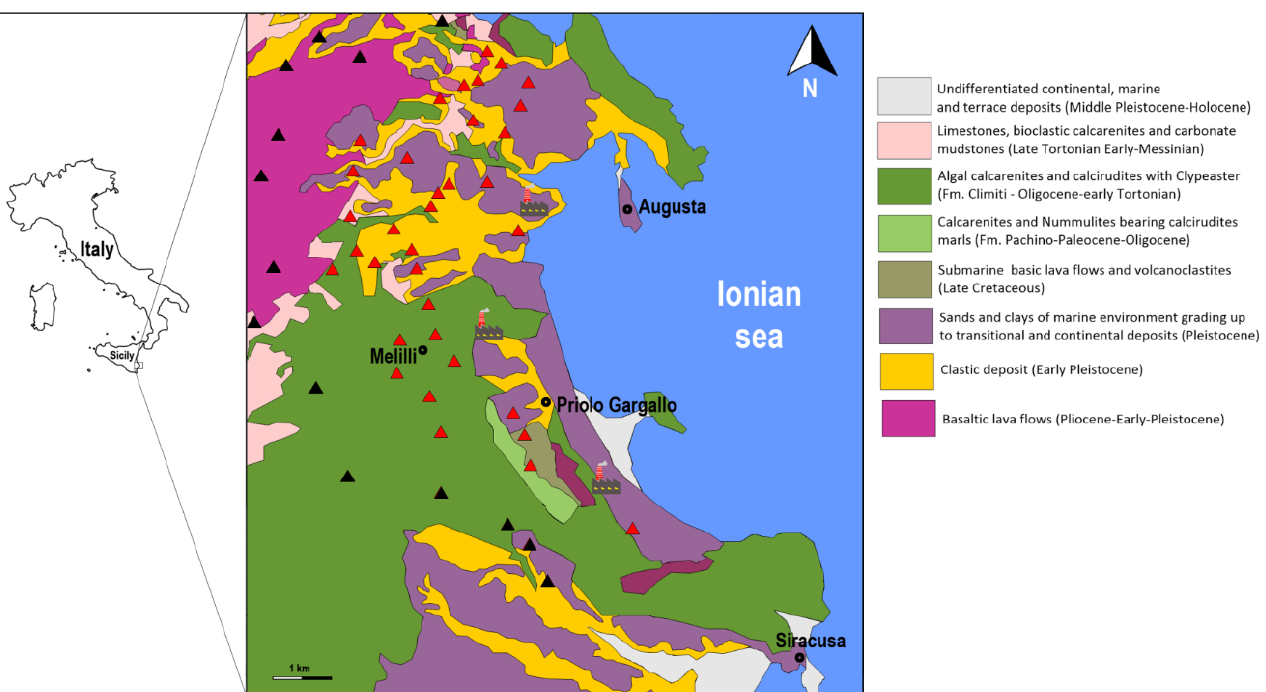
Figure 1. Geological sketch map of the study area with the location of the sampling sites (modified from [35]). Control samples (SUBIND) collected in rural environment (black triangle); lichen samples (IND) collected near the Syracusan petrochemical complex (red triangle).